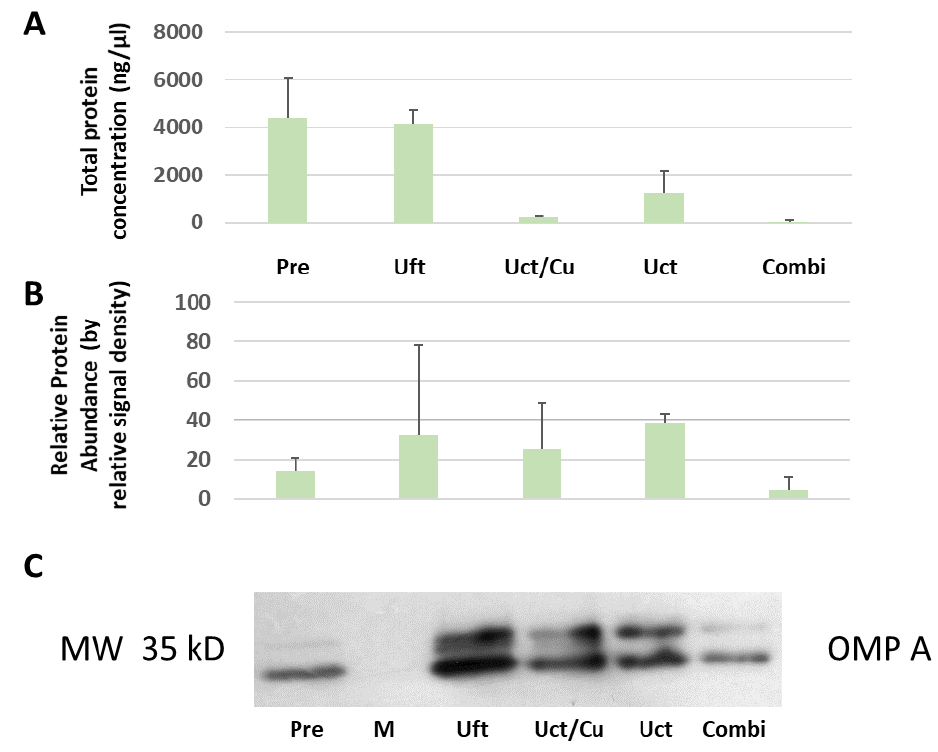
Figure 2. Biochemical characterization of OMVs. ( A ) The total protein concentration of various OMV preparations was measured, after using different methods for concentration (Pre, before concentration; Uft, ultrafiltration; Uct, ultracentrifugation; Cu, sucrose cushion). The strongest signal is found in the sample before concentration (see sample Pre). ( B ) Densitometry of immunoblots for ompA shows the relative abundances of OMV marker ompA. The strongest signal is found in the ultracentrifuged (see sample Uct). ( C ) Representative immunoblotting for the E. coli outer membrane protein A (ompA). Using this date, conclusions about the purification capability of the different methods can be made (see Table 2). All error bars indicate standard deviations. N ≥ 2. Table 3. OMV-mediated fluorescence